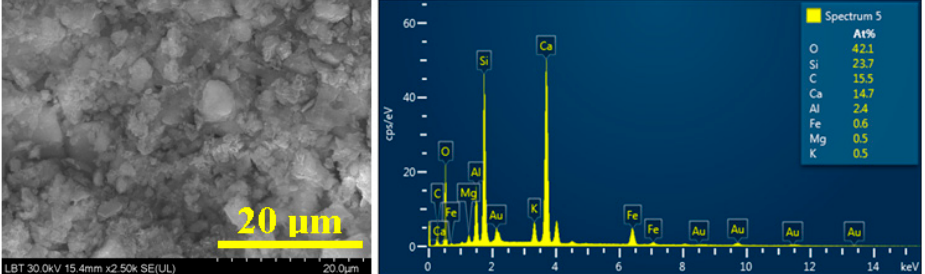
Figure 6. SEM image for the resting soil and the corresponding EDS spectrum.